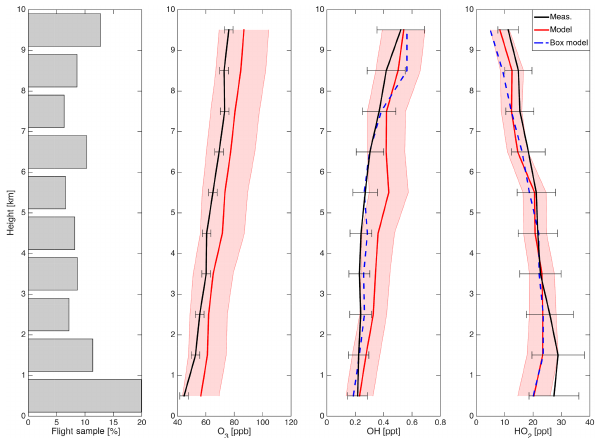
Figure 2. Vertical profiles of median modeled (red) and measured (black) ozone, OH, and HO 2 for INTEX-A flight data binned by kilometer. Gray bar graph shows percent of flight data within each vertical bin. Shaded regions represent 1 σ of the model ensemble; error bars on measurements are uncertainty at 1 σ confidence. Blue line represents results from the box model (Ren et al., 2008).